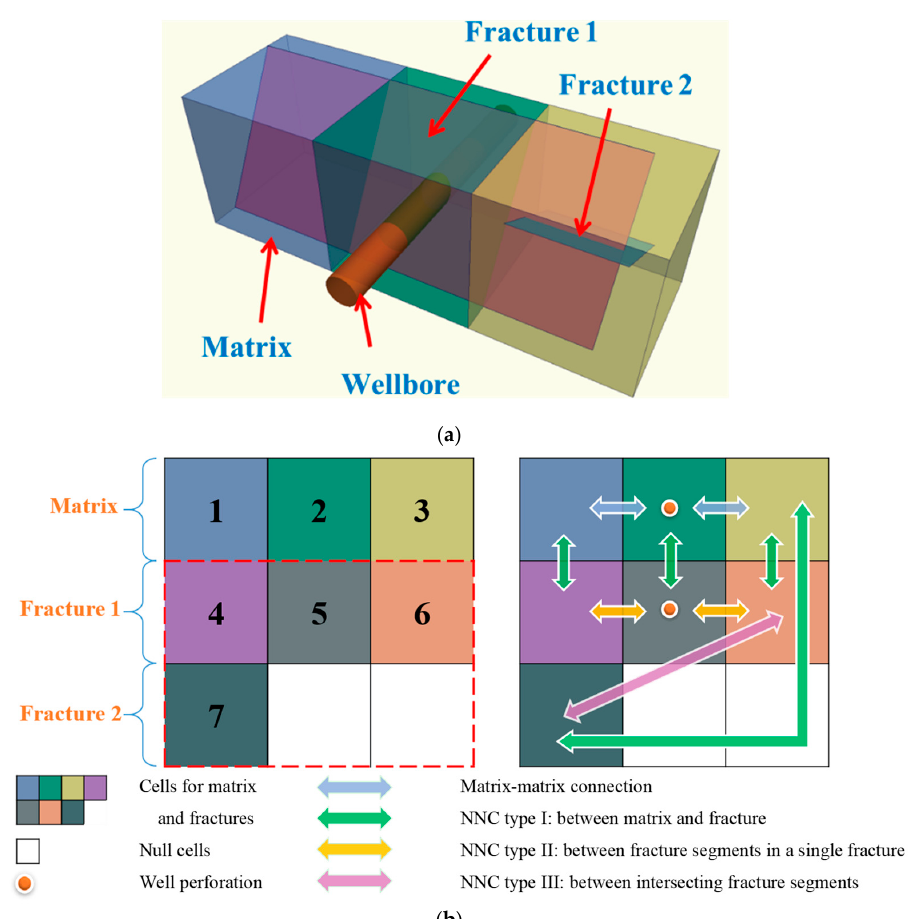
Figure 1. The non-intrusive EDFM technology in conjunction with commercial reservoir simulator to efficiently model 3D complex fractures: ( a ) Physical domain; ( b ) Computational domain [30].